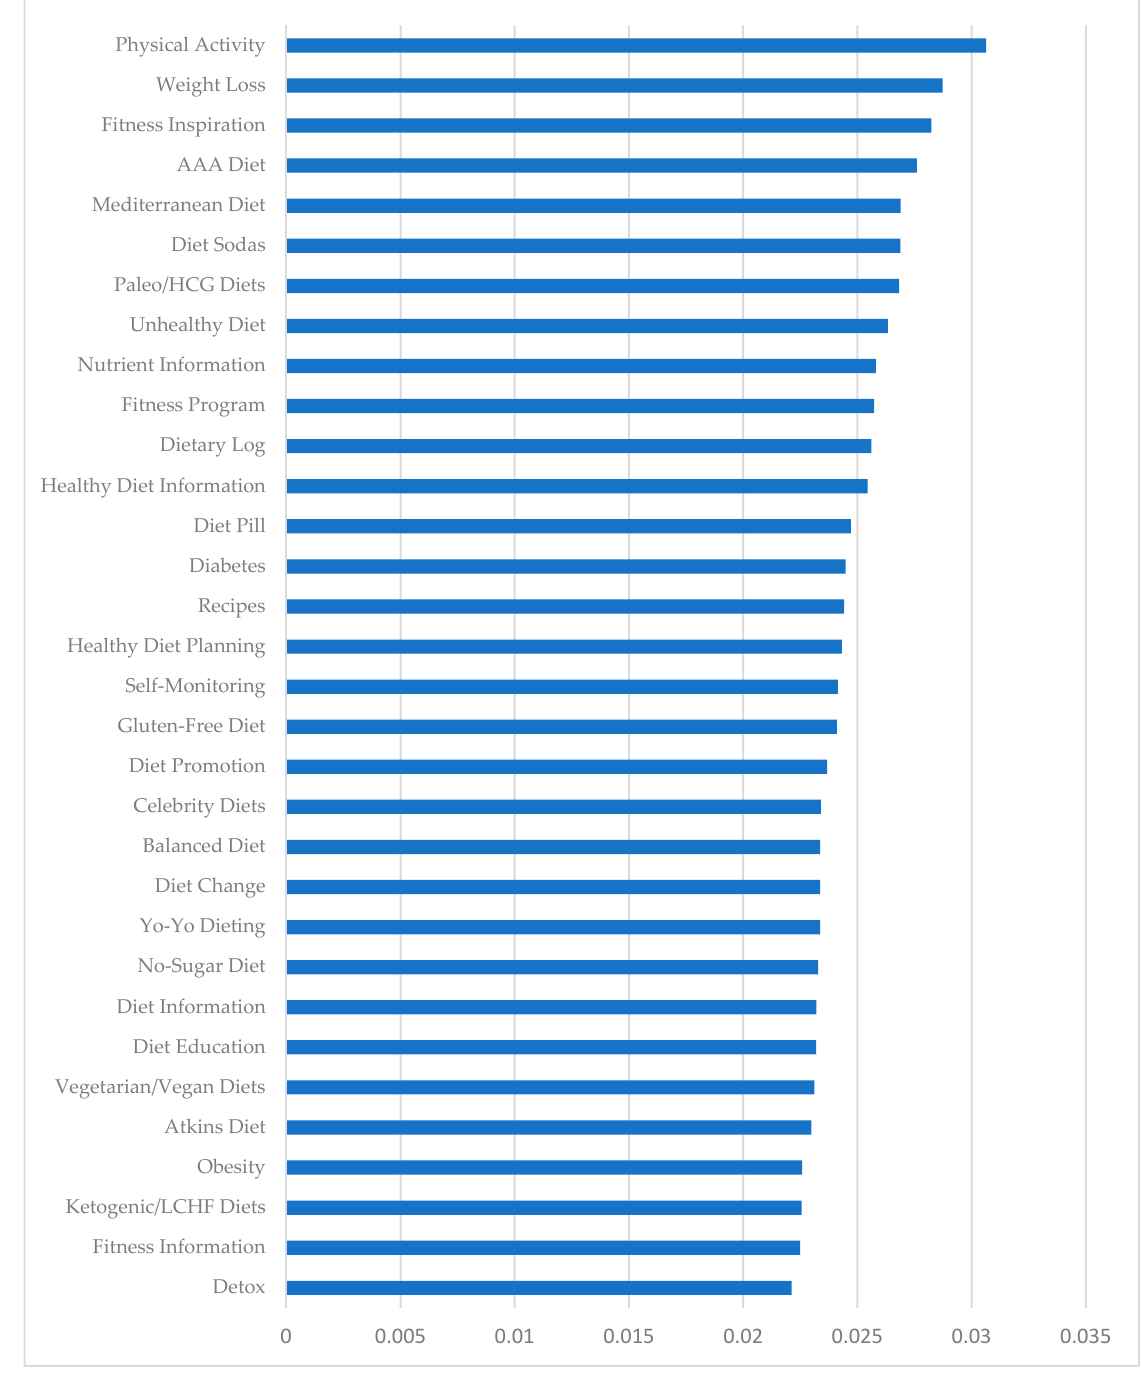
Figure 3. Average weight of topics per tweet.